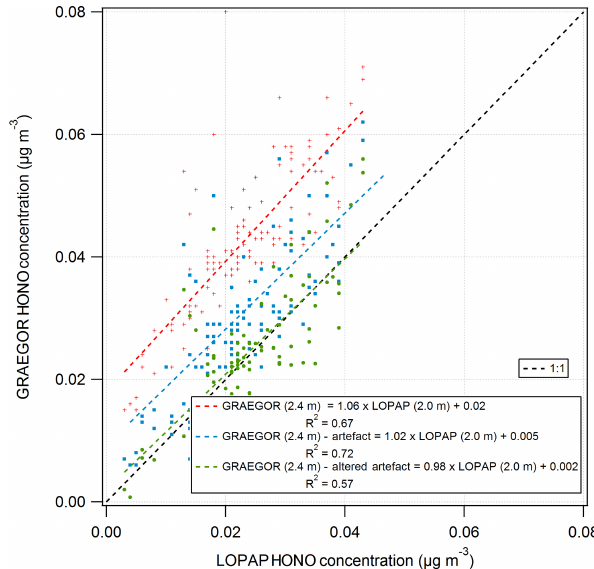
Figure 14. Simple linear regression analyses between GRAEGOR (2.4m) and LOPAP (2.0m) without artefact reduction (red), with Spindler’s artefact reduction (blue) and with a modified Spindler’s artefact reduction (green) applied to GRAEGOR (2.4m) HONO